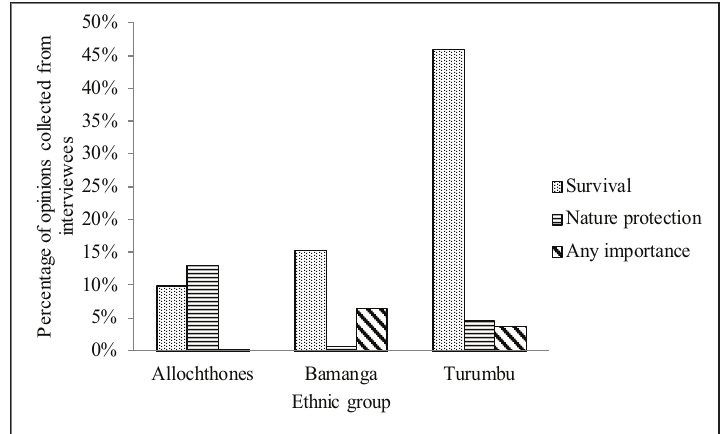
Figure 6. Importance of Yangambi Biosphere Reserveto local communities in the area.